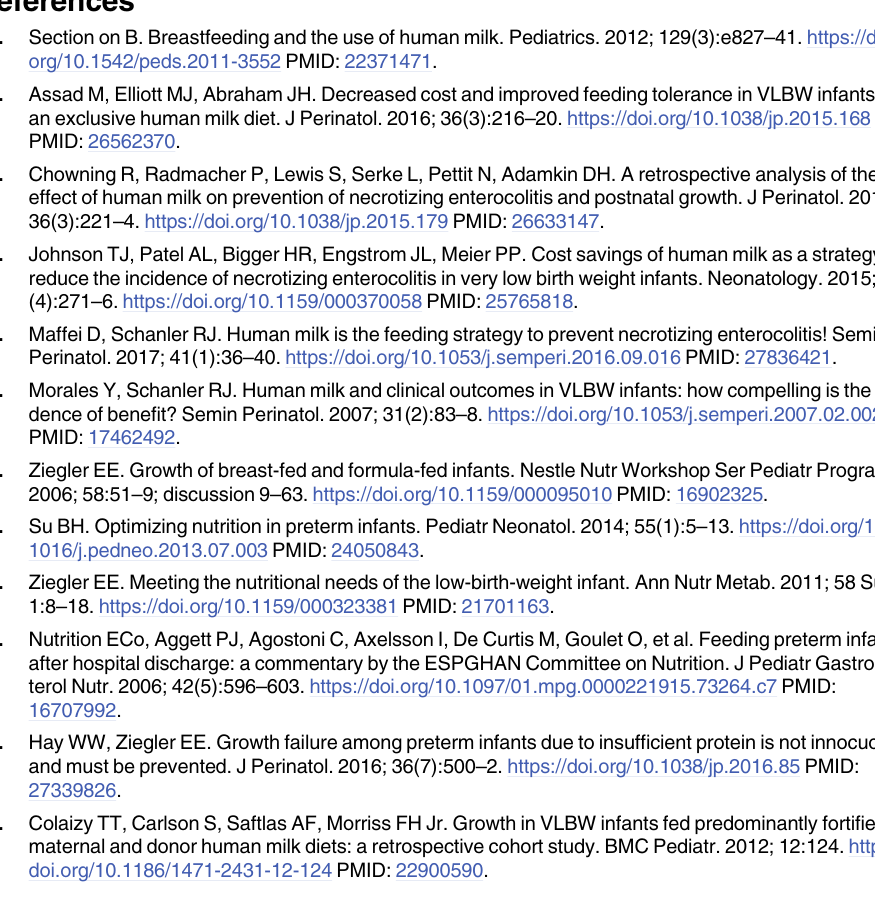
S1 Fig. The number of data points each infant contributed. (TIF) S1 Table. Demographic data for included